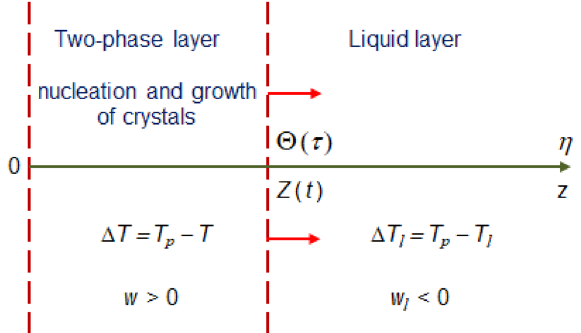
Figure 1. A schematic illustration of crystallization with an undercooled layer where nucleation and growth of crystallites